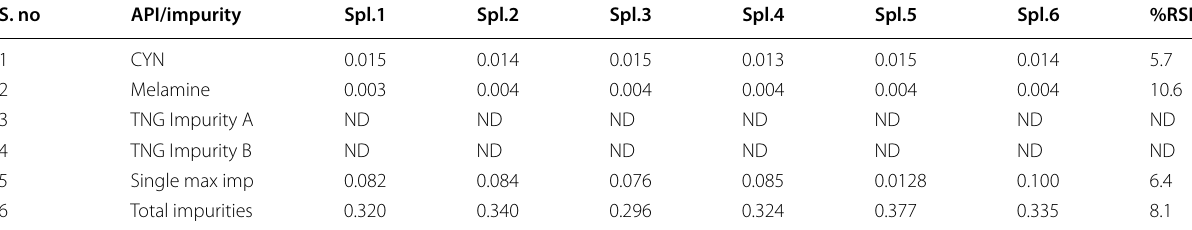
Table 5 Method precision study